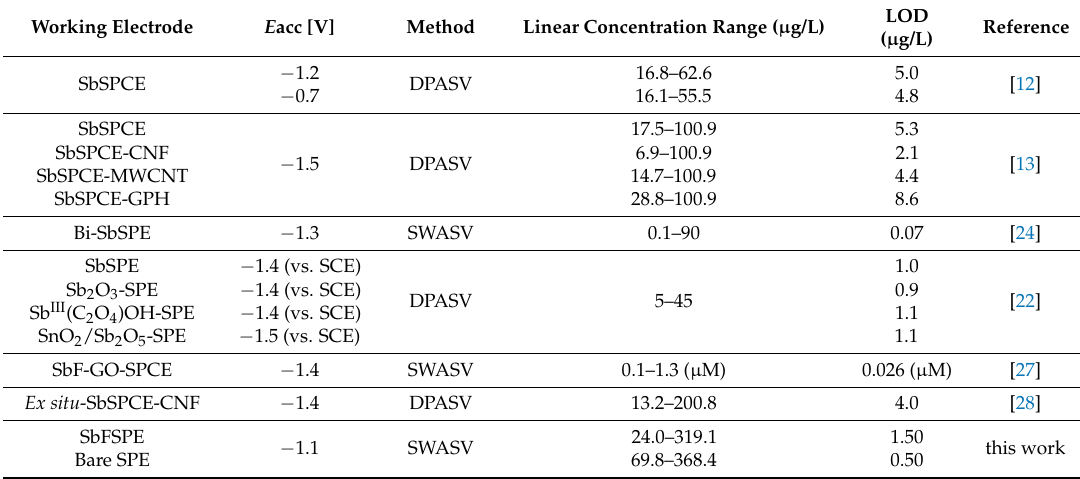
Table 1. Comparison of different SPEs performances for Pb(II)